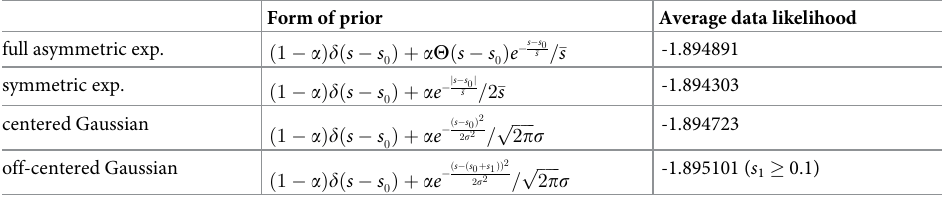
Table 1. Likelihoods for alternative forms of log-change prior distribution (donor S2; day 0-day-15). Note that the off-centered Gaussian was strictly off-centered, explaining its lower performance relative to the centered Gaussian despite having more degrees of freedom. Form of prior Average data likelihood full asymmetric